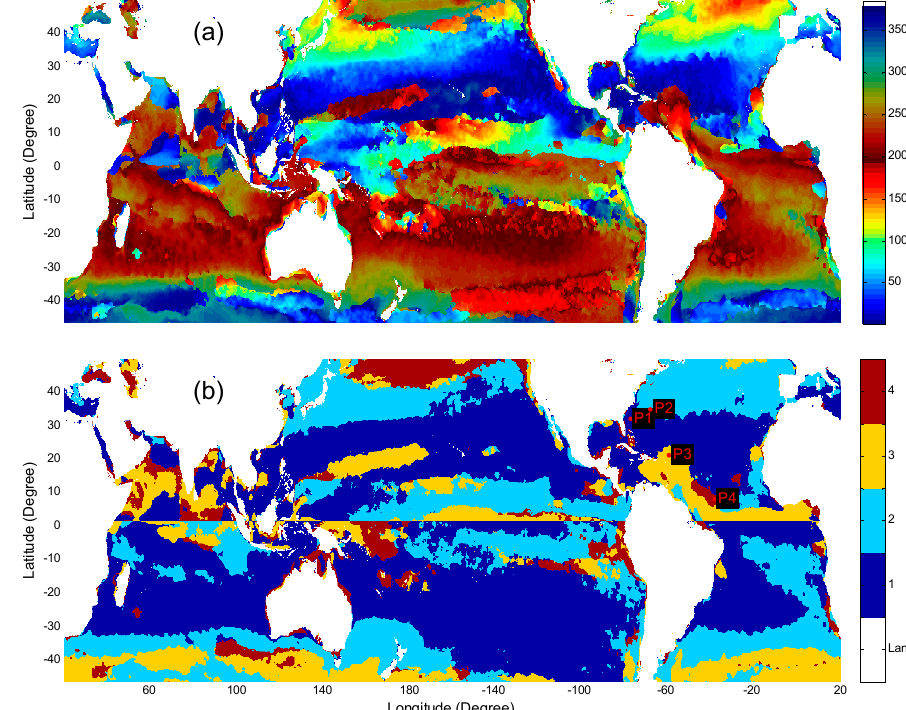
Figure 12. ( a ) The bloom period identified as the peak of the largest bloom using the fitted values of Equation (3) in the unit of day of year. ( b ) The regions of bloom timing classified into four seasons of boreal winter (December–February, marked as Class 1), boreal spring (March–May, Class 2), boreal